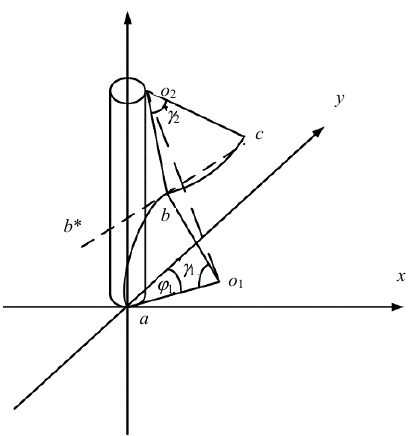
Fig. 2 Shape sensing theoretical